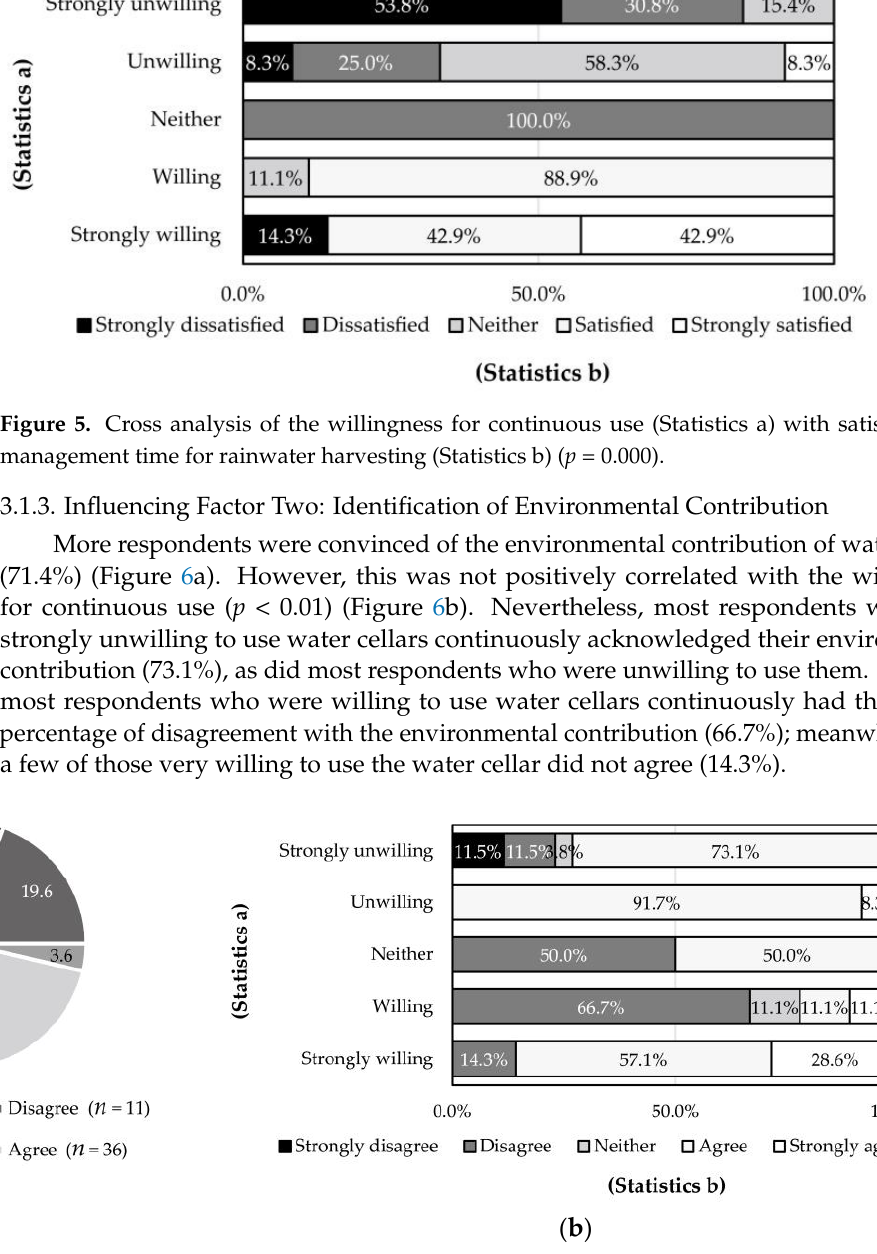
Figure 6. Identification of the environmental contribution of water cellars and its cross-analysis with the willingness for continuous use: ( a ) identification of the environmental contribution of water cellars (keeping yards, roads, and public spaces clean); ( b ) (statistics b) cross-analyzed with the willingness for continuous use (statistics a) ( p =